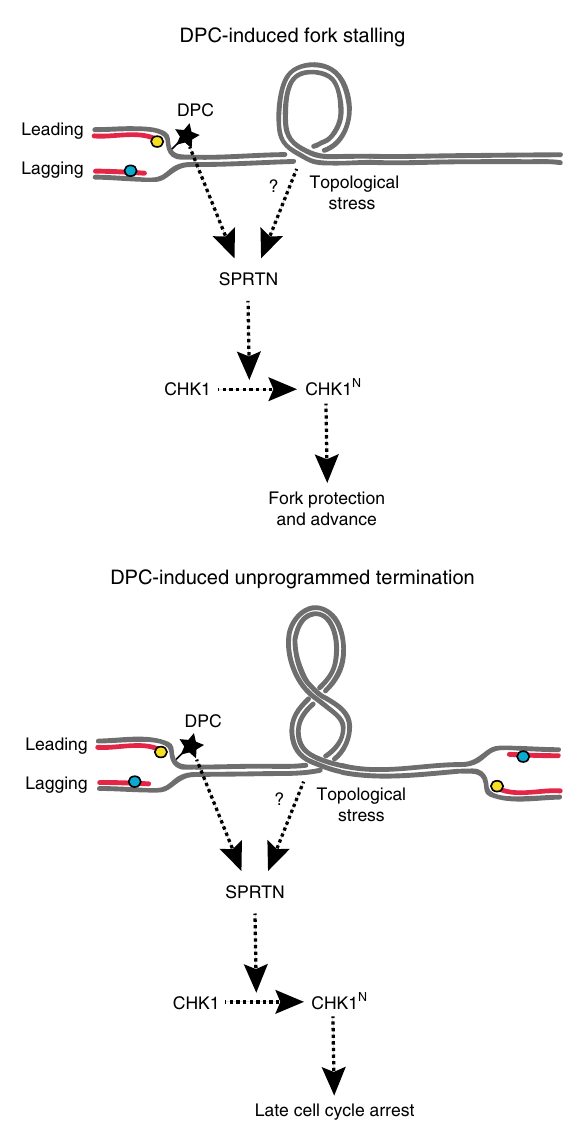
Fig. 1 A model for DPC-induced Chk1 activation during replication. DPCs